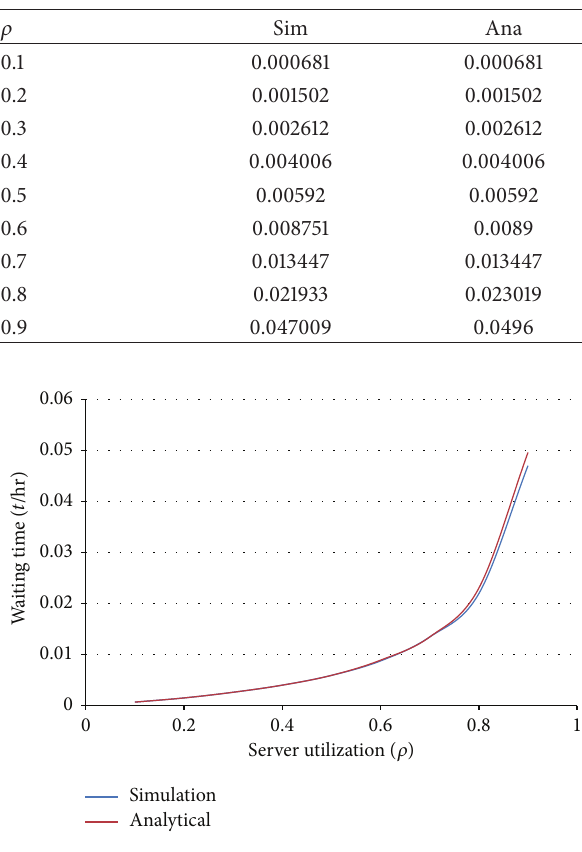
Figure 3: Simulation and